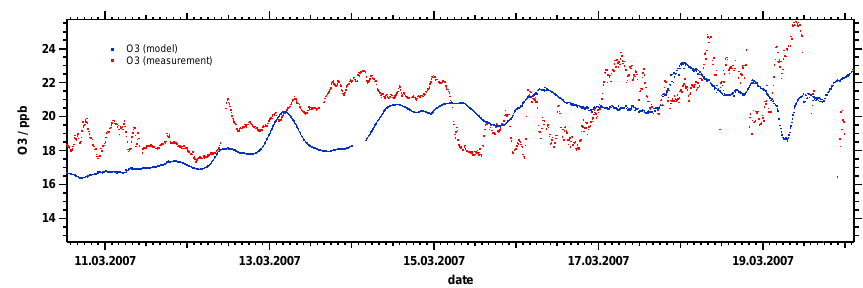
Figure 3. Time series of observed (red) and simulated (blue) ozone mixing